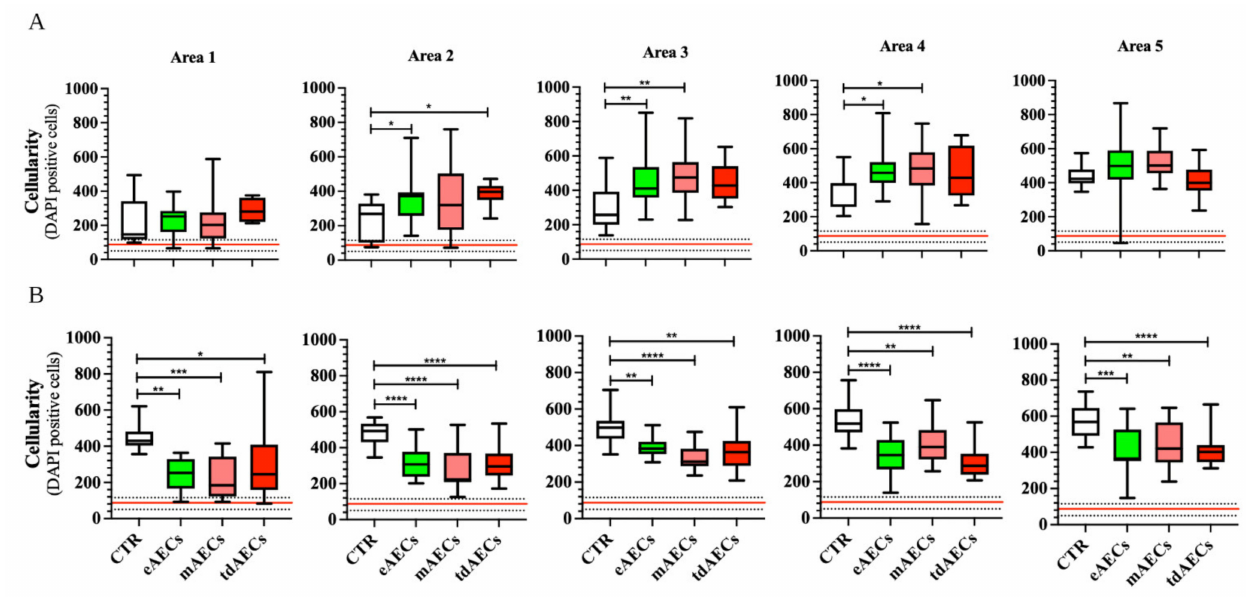
Figure 7. Spatial distribution of cellularity in healing tendons at day 14 and day 28. Box plots showing the number of cells within spontaneous healing tendons (CTR) and treated tendons with eAECs, mAECs, and tdAECs within 5 different analyzed fields in all 6 areas (from area 0 to area 5) after ( A ) 14 and ( B ) 28 days of tendon injury. Values were considered statistically significant for * ( p < 0.05), ** ( p < 0.01), *** ( p < 0.001), and **** ( p < 0.0001). The quantitative data were expressed as mean ±